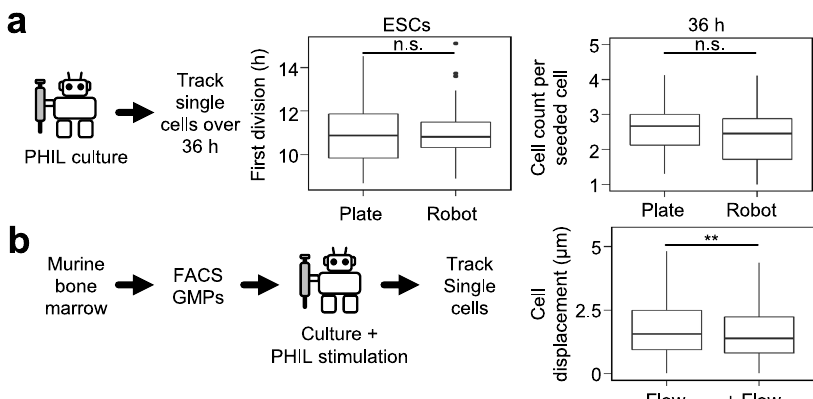
Fig. 6 PHIL successfully conducts media exchanges without disrupting sensitive samples and cell cultures. a Mouse embryonic stem cells (ESCs) proliferate normally during automated PHIL culture experiments. ESCs were cultured and imaged in PHIL for 36 h. Mean time to fi rst division with and without PHIL were 12.3 and 12.5 h, respectively ( p = 0.72, two-tailed t -test, n = 3 experiments). ESC counts per seeded cell after 36 h of culture with and without PHIL were 2.6 and 2.3 cells, respectively ( p = 0.32, two-tailed t -test, n = 3 experiments). Box plot features, from top to bottom, represent maximum, 3 rd quartile, median, 1st quartile, and minimum values. b PHIL media exchanges do not interrupt cell tracking procedures. Murine GMPs cultured on in CD43-coated 24-well plates wells were imaged and tracked during automated media exchanges. Mean GMP movement or displacement in unwashed versus washed wells were 2.1 versus 1.8 µ m, respectively, did not displace cells ( p = 0.003, two-tailed t -test, n = 3 experiments). Box plot features, from top to bottom, represent maximum, 3rd quartile, median, 1st quartile, and minimum values.